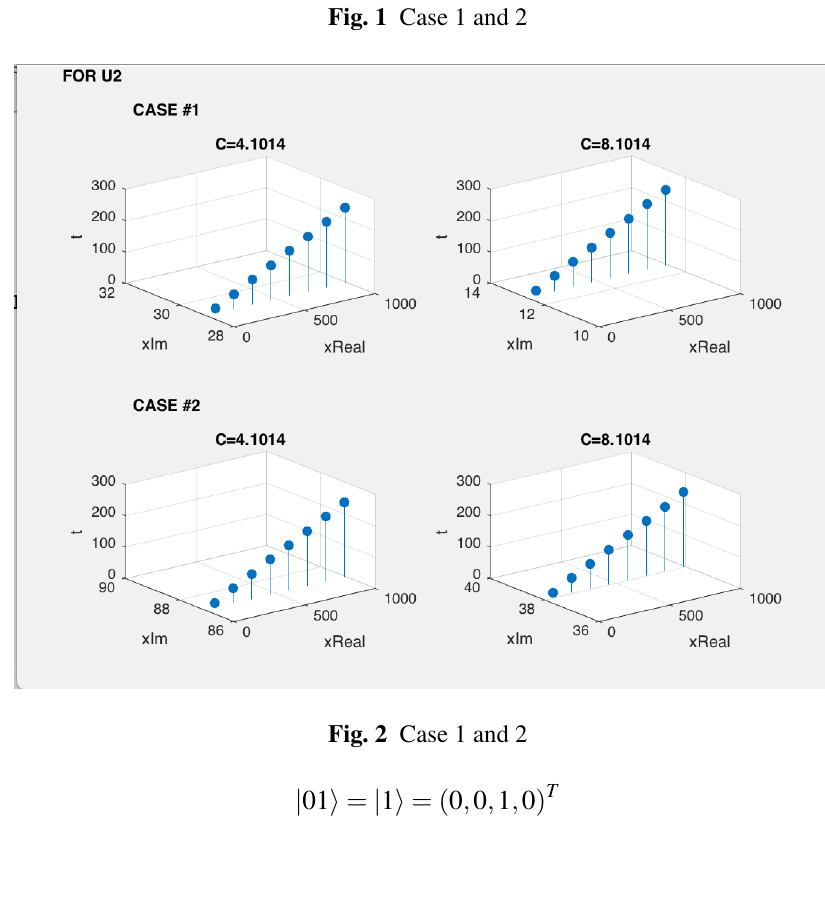
Fig. 1 Case 1 and 2